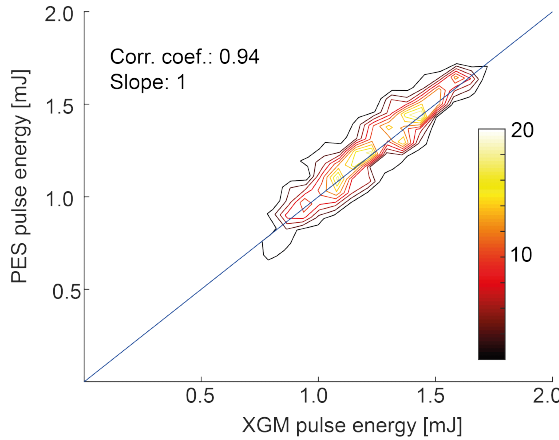
Figure A5. Contour plot of pulse energy correlation for 500 pulses measured with XGM and PES with U2 tuned to 910 eV. Bins are 0.1 mJ × 0.1 mJ. We found the correlation coefficient to be